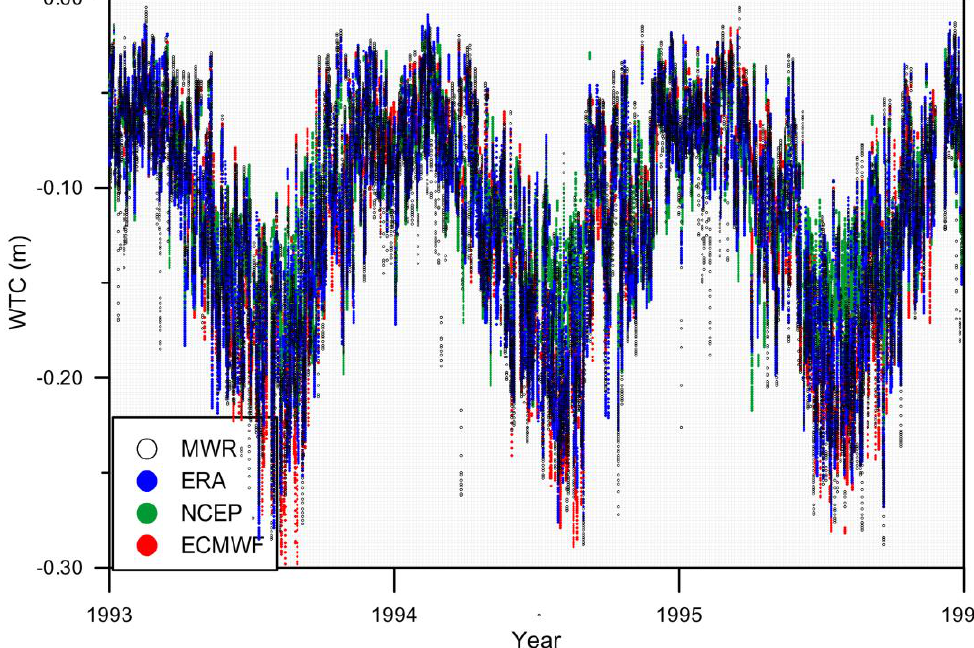
Figure 12. WTC for all T/P measurements over the Caspian Sea for three years (1993–1996). Only measurements over inland water with valid MWR correction were